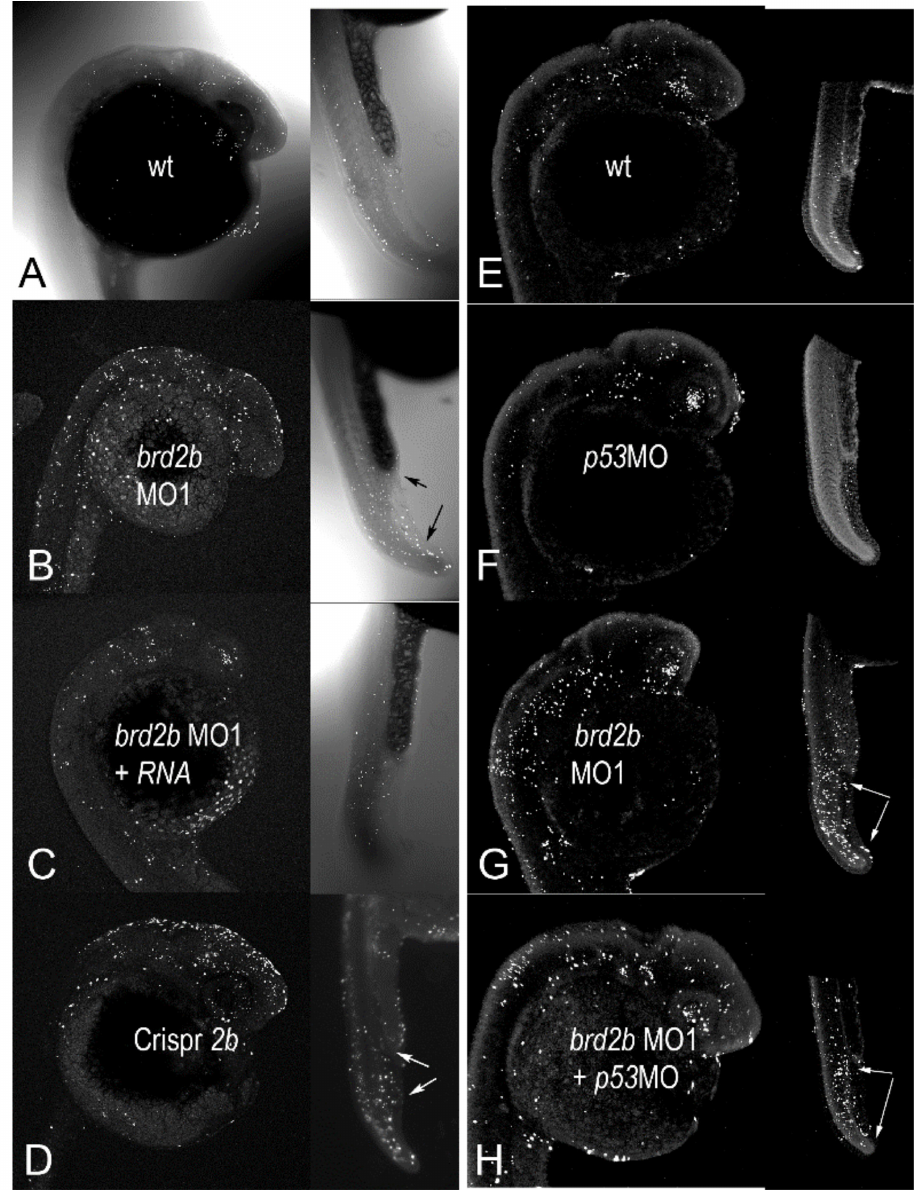
Figure 4. Brd2b knockdown increases cell death in the CNS of prim 5 morphant embryos but re- duces cell death in the cloaca of the pronephros. Dark-field images of representative 24 hpf prim5 embryos treated as indicated and after TUNEL assay for apoptotic nuclei. Panels ( A – D ) (heads and trunks) show treatment groups for testing gene-specificity of apoptotic effects: ( A ) uninjected; ( B ) brd2b MO1-injected; ( C ) brd2b MO1 + HsBrd2 RNA-injected; and ( D ) Crispr-Cas9- brd2b -disrupted embryos. HsBrd2 RNA co-injection rescues, while Crispr-Cas9 treatment phenocopies, excess apop- tosis in the brain and trunk overall of morphants, showing effects are specific to brd2b . Arrows indicate specific regions of reduced apoptosis at the cloaca (upper arrows) and increased apoptosis in the PBI (lower arrows) in the ventral trunk of morphant and Crispr-Cas9-treated, but not control or rescued embryos. Panels E – H (heads and trunks) show treatment groups for testing p53-dependent off-target effects: ( E ) uninjected; ( F ) p53 MO-injected; ( G ) brd2b MO1-injected; and ( H ) brd2b MO1 − + p53 MO co-injected. p53 MO co-injection does not abrogate excess apoptosis in morphants, ruling out off-target effects as the cause of cell death. See Figure 5 for quantitative TUNEL data from these studies. See Supplementary Figure S2 for images on HsBrd2 RNA control